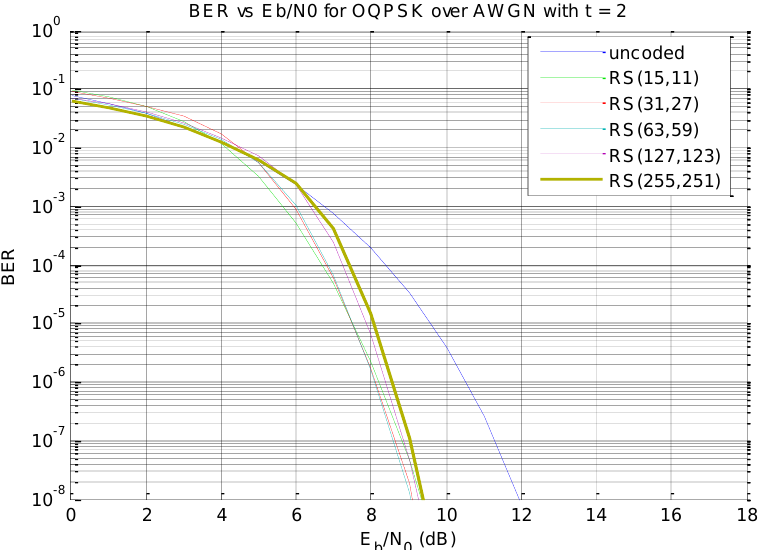
Figure 11. RS error performance for OQPSK over AWGN channel with t =2 and increasing